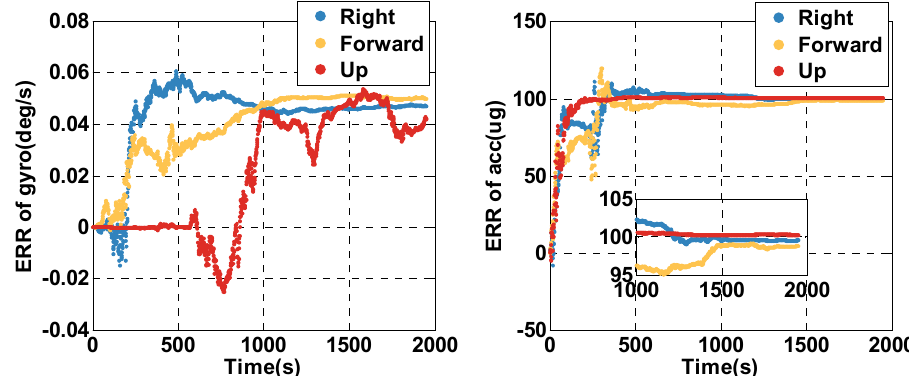
Figure 5. The estimated angular rate and specific force bias of gyro and accelerometer (acc) in the open-sky case. ERR = Error.